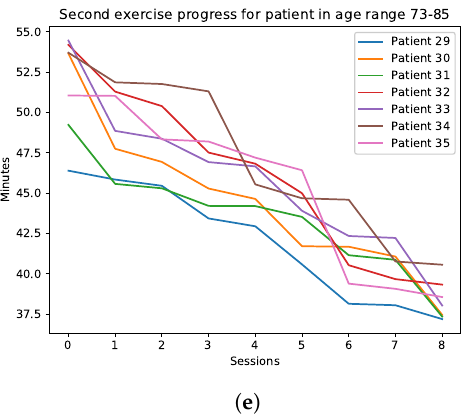
Figure 15. The performance of the patients for the fifth exercise. The plots are divided by age: ( a ) 25–36, ( b ) 37–48, ( c ) 49–60, ( d ) 61–72, ( e ) 73–85.